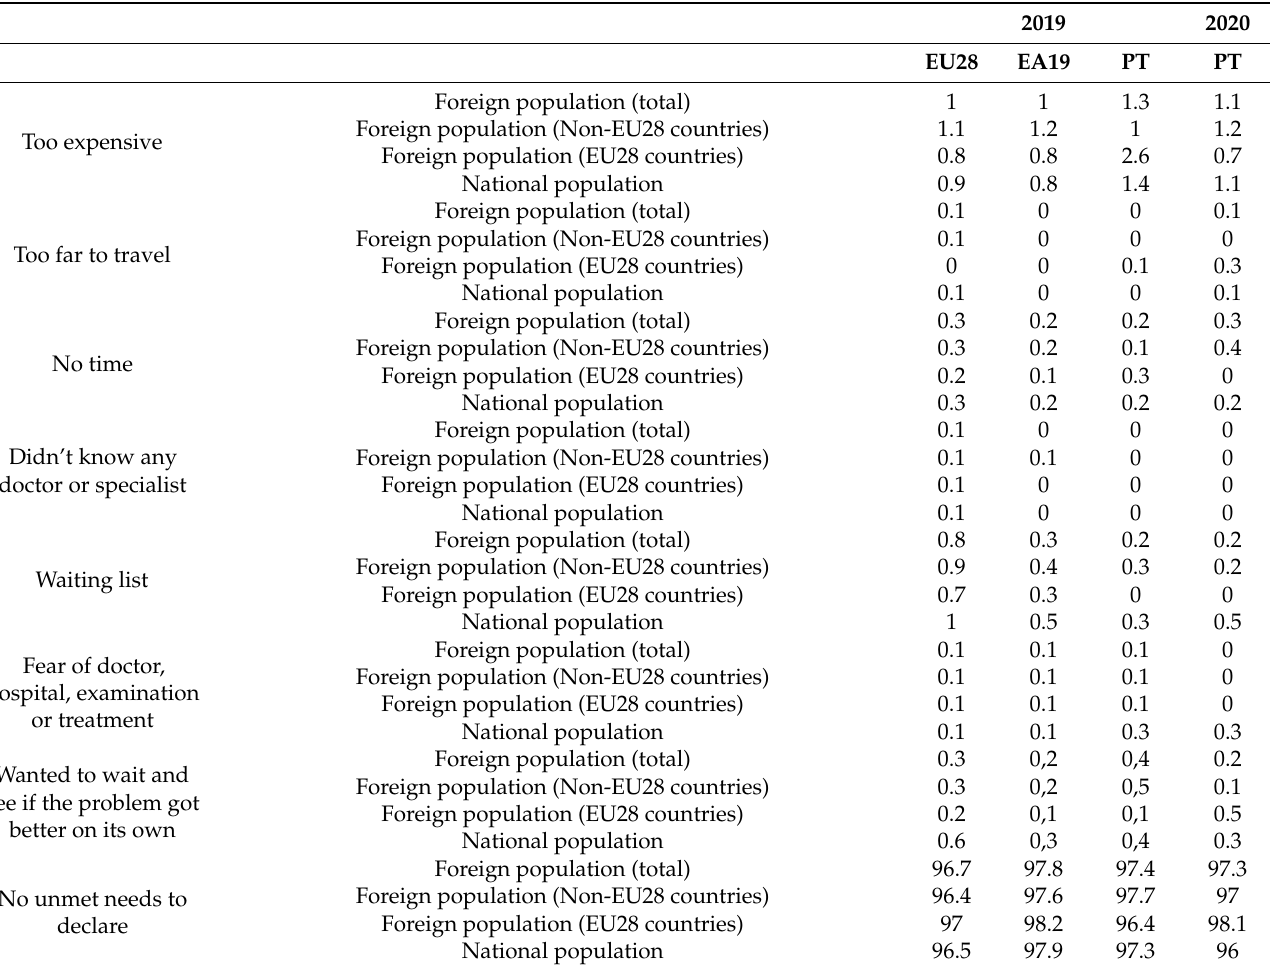
Table 3. Self-reported unmet needs for medical examination (main reasons declared) by group of citizenship, European Union, Euro Area and Portugal, 2019–2020